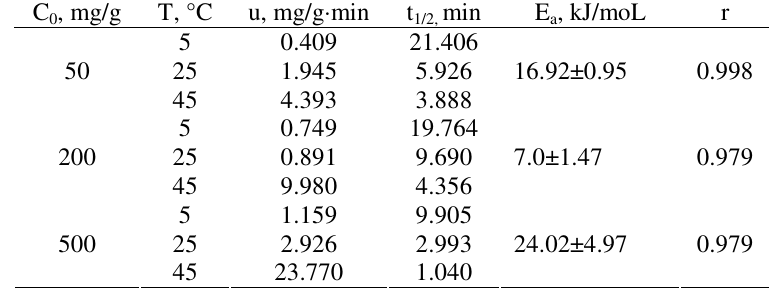
Table 9. Kinetic parameters for the second order adsorption model of PEG (10000)